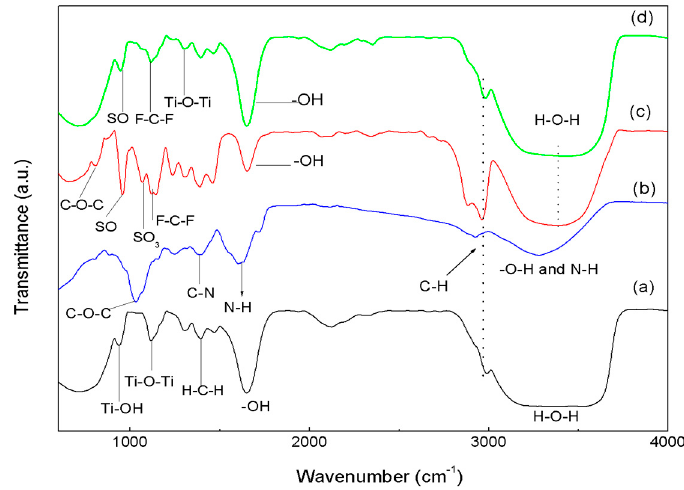
Figure 1. FTIR spectrum of ( a ) TiO 2 ; ( b ) laccase; ( c ) Nafion; ( d ) TiO 2 /NAF/LAC.